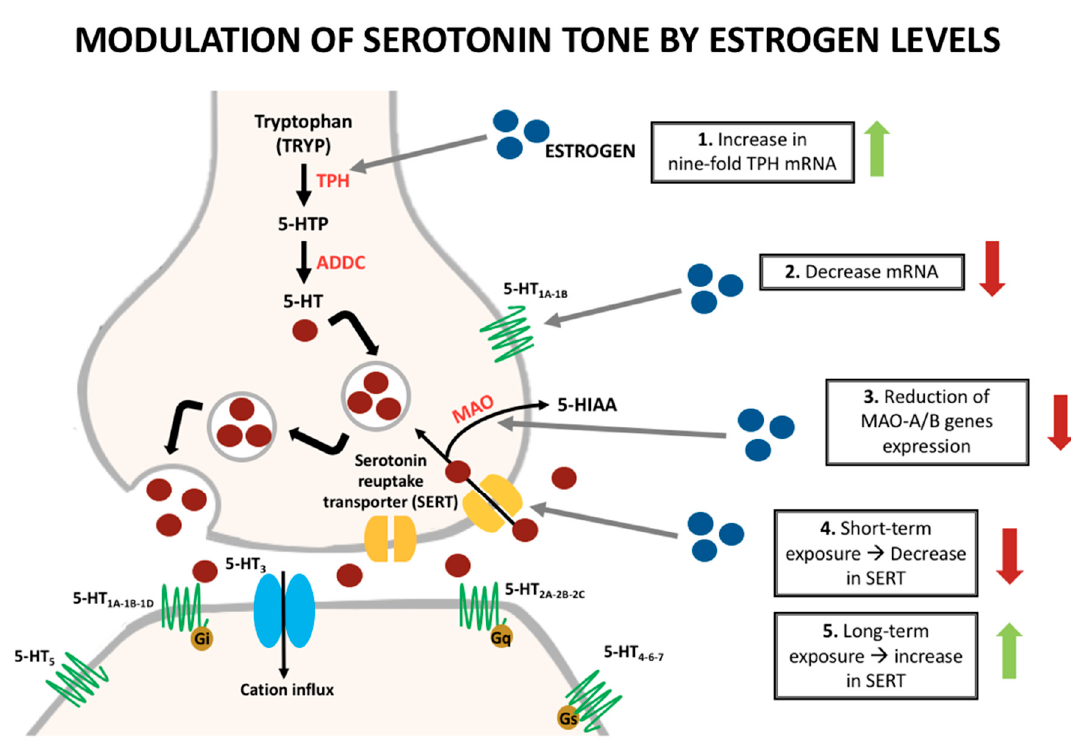
Figure 1. Modulation of serotonin synthesis and metabolism by estrogens.